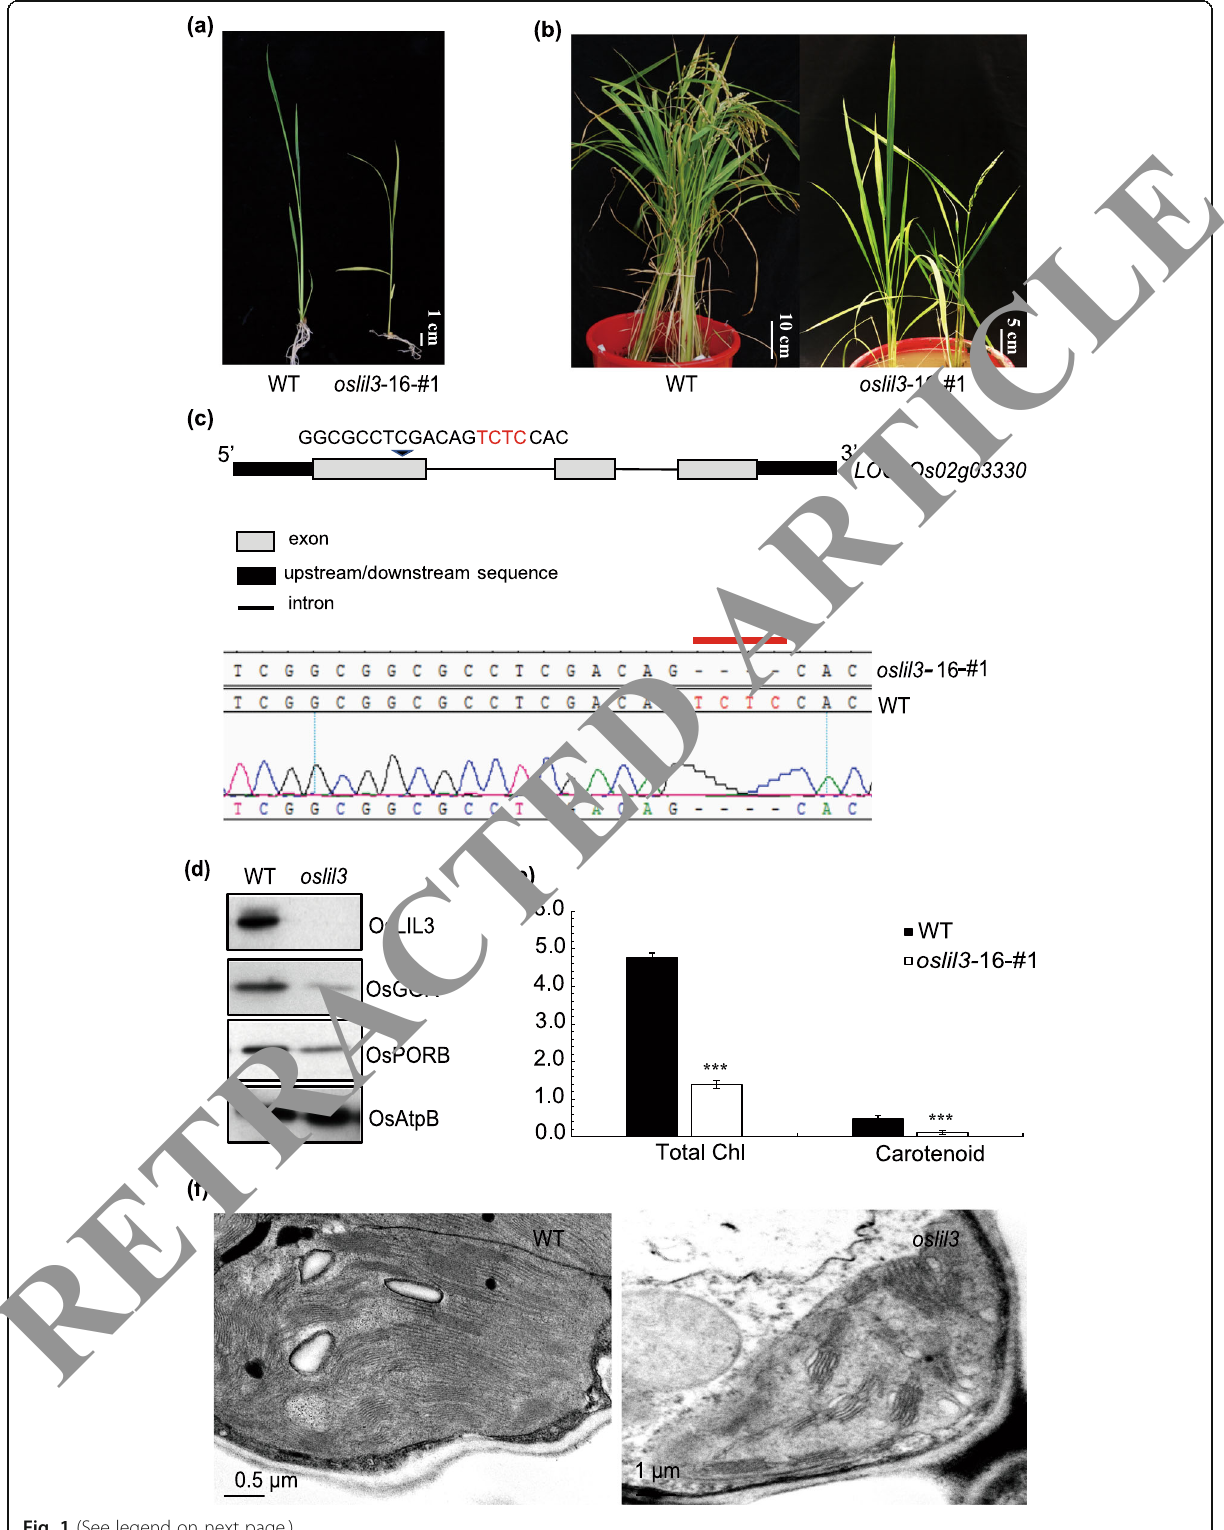
Fig. 1 (See legend on next